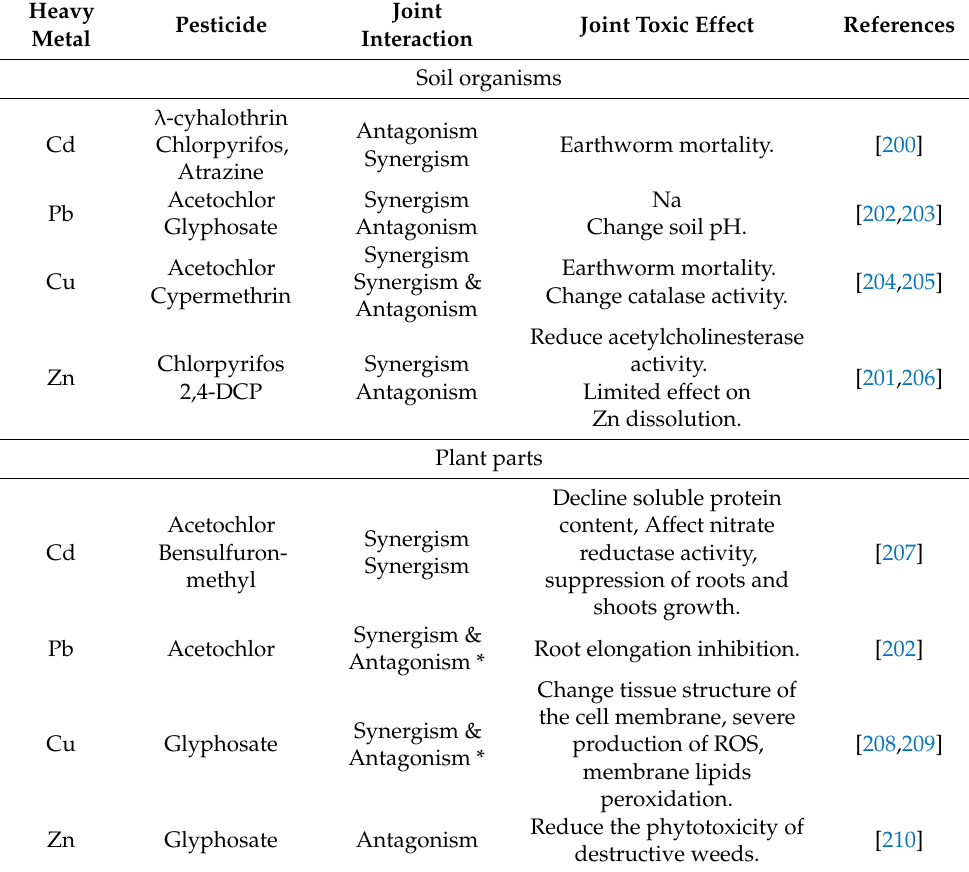
Table 7. Interaction between heavy metals and pesticides and their joint toxic effect on agricultural soil and